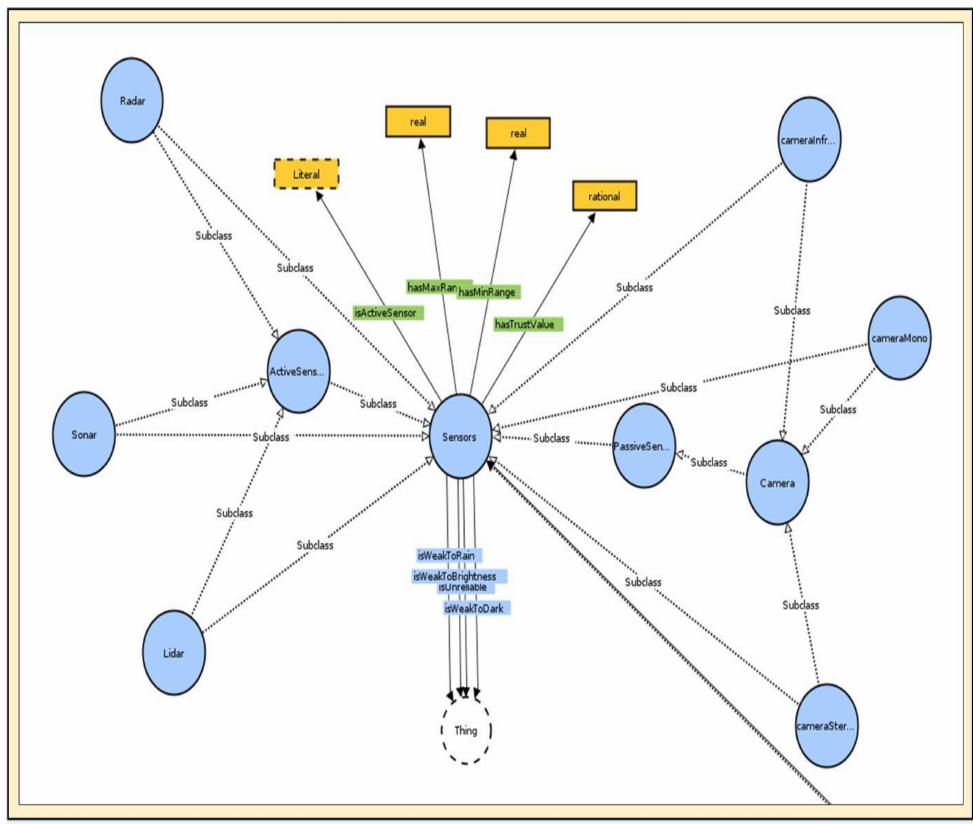
Figure 12. Relationships and properties of the Sensors